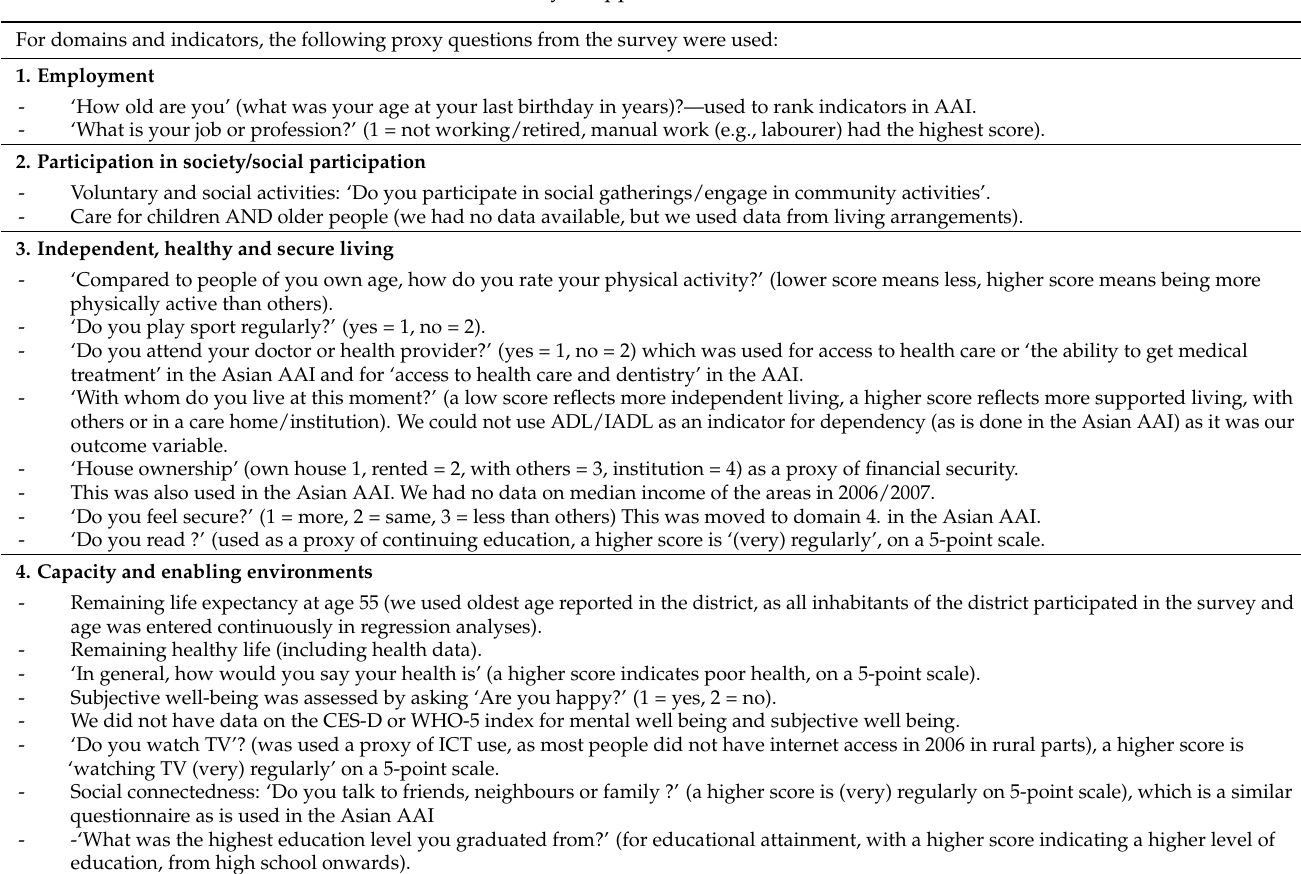
Figure 1. The domains and the indicators of aggregated Index, AAI. Table 1. Questions from the 2006/7 survey to approximate AAI indicators in different sites in Indonesia.